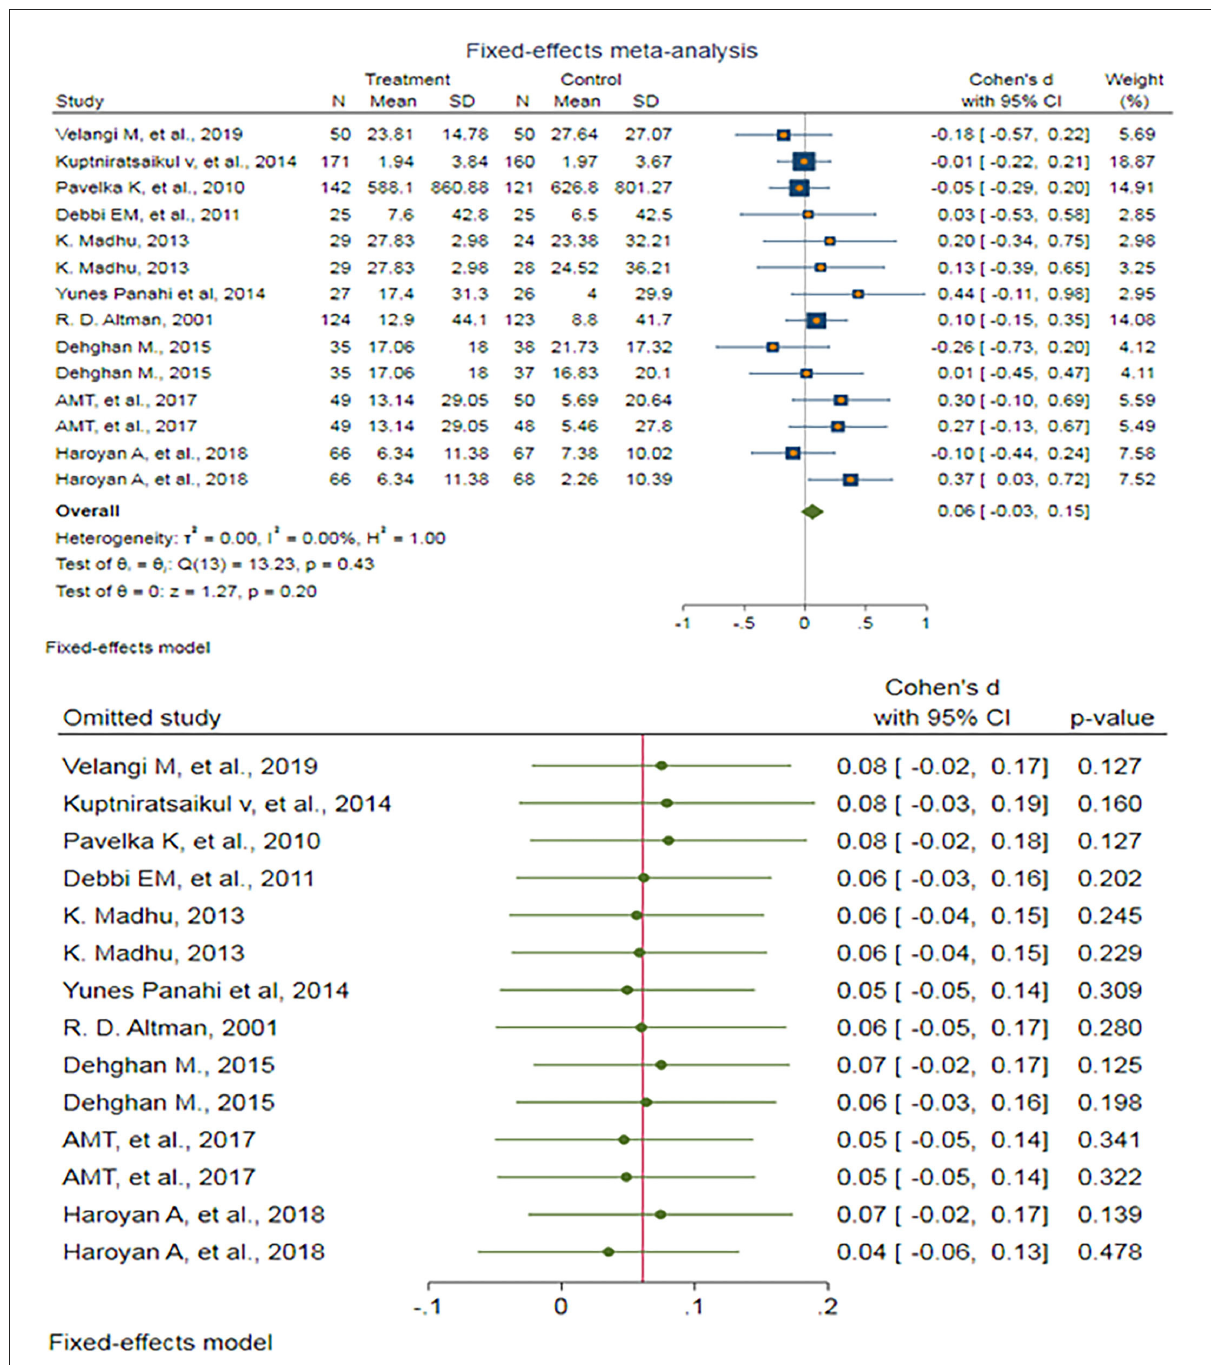
FIGURE3 (UP) A forest plot for the association between antioxidants and the outcomes of interest in OA based on the Western Ontario and McMaster Universities Osteoarthritis Index (WOMAC) combined pain score. (DOWN) Forest plot of sensitivity analysis for the association between antioxidants and the outcomes of interest in OA based on the WOMAC combined pain score.